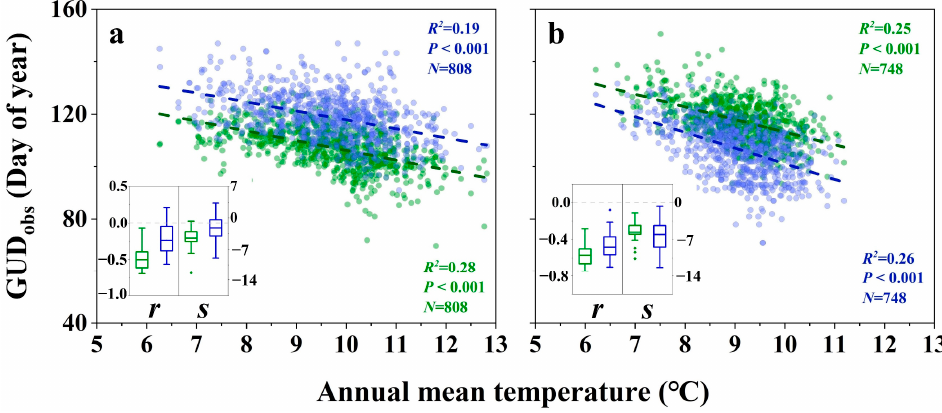
Figure 4. Relationships between annual observed green-up dates (GUD obs ) of deciduous forest (green) and herbages (blue) and annual mean temperature for all forest-herbage-mixed (FHM) sites with GUD obs-forest < GUD obs-herbage ( a ) and with GUD obs-herbage < GUD obs-forest ( b ) The embedded box plots show the correlation coefficients (r) and slope (s) of regression lines, which indicate the change trend of GUD with the increased annual mean temperature for each FHM site.